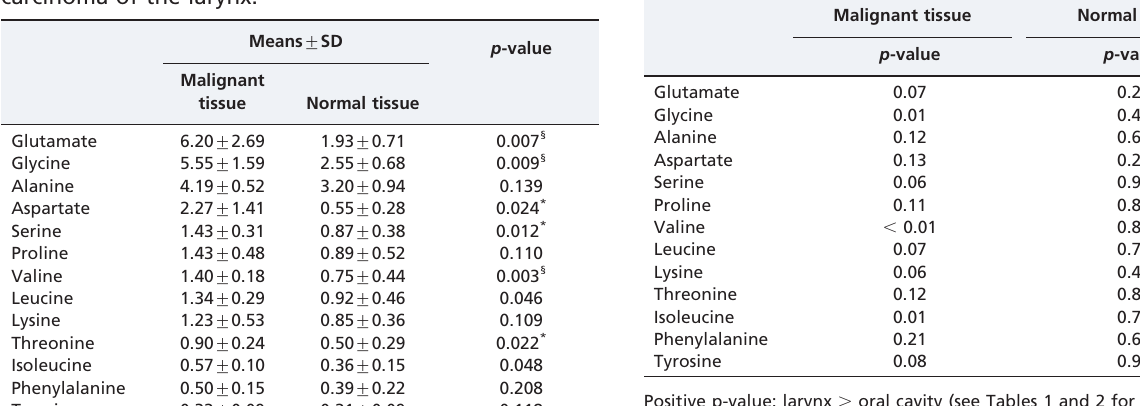
Table 1 - The amino acid content ( m mol/g) in malignant and normal tissues from patients with squamous cell carcinoma of the larynx.